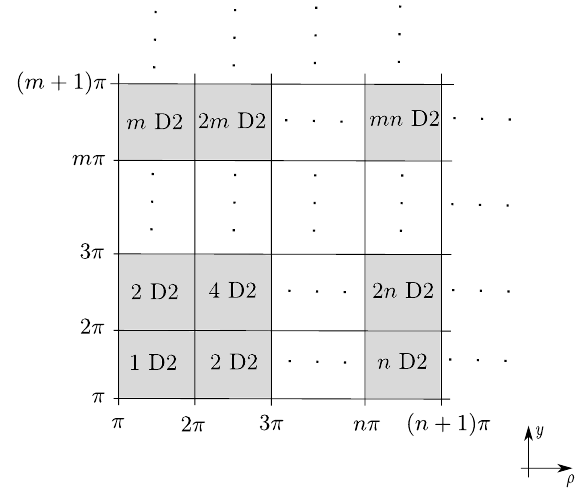
Figure 3 . Brane set-up associated to the AdS 2 solution (2.8) (in units of Q D 6 = 1